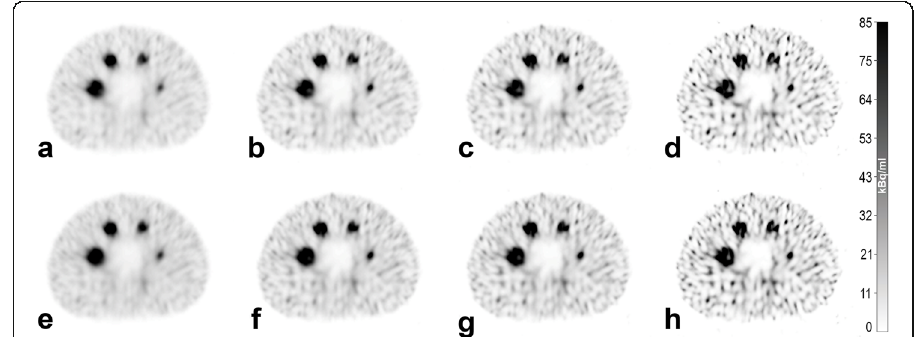
Fig. 3 SPECT images reconstructed from data acquired with the clinical acquisition protocol. Reconstruction was performed with 2i/10s ( a and e ), 4i/10s ( b and f ), 5i/15s ( c and g ) and 24i/10s ( d and h ). Scatter correction was performed with a – d SCF = 1.10 and e – h SCF = 0.41. SPECT images ( a and e ) were reconstructed with postfiltering and represent the subjectively preferred image quality for reading. a represents our institutional standard for diagnostic imaging and reconstruction. All SPECT images have an identical window level and